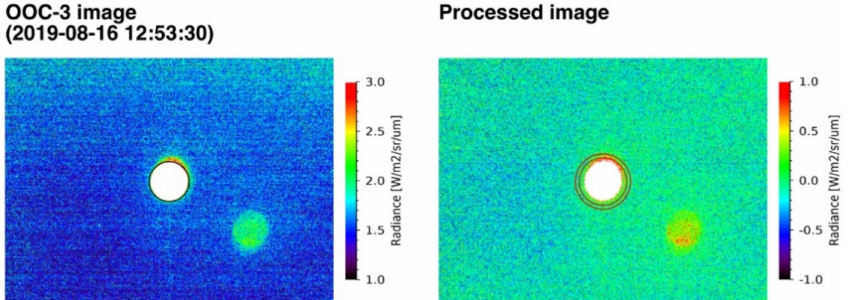
Figure 6. Low-illumination enhanced image of Figure 4 ( left ) and processed one after the subtraction of background radiance ( right ). Moon position was centered, and 500 × 375 pixels of surrounding background are displayed. Black circle in the left panel indicates the defined Moon limb ( L P + 2 pixel). The additional background level was calculated from the red annular region shown in the right panel (see text for detail